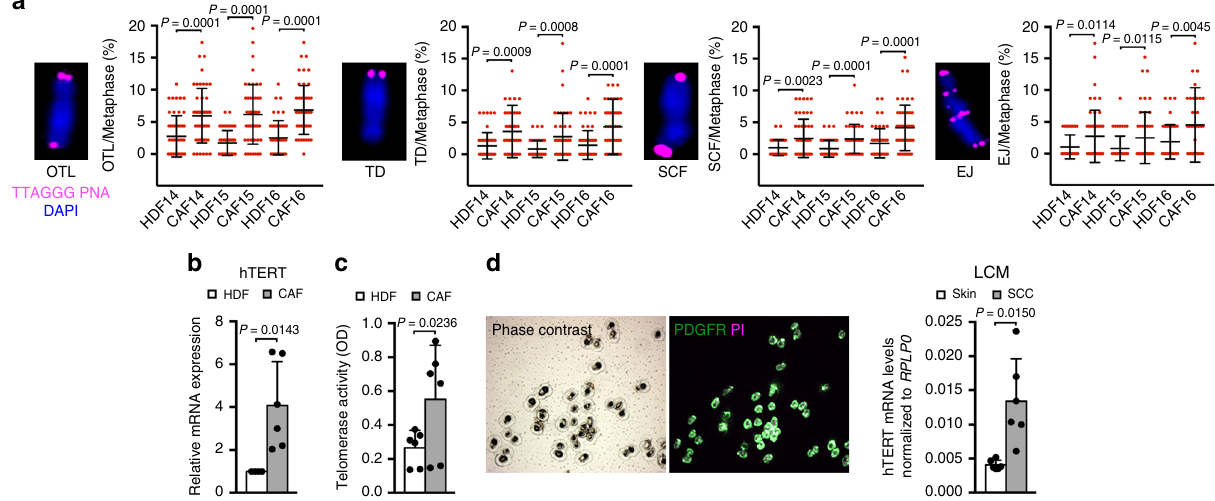
Fig. 4 CAFs display persistent genomic instability and hTERT reactivation. a Representative images and quanti fi cation of the percentage of chromosomes carrying OTLs, TDs, SCFs, and EJs per metaphase in three CAF and matched HDF strains. Data are shown as in Fig. 3f, g. Mean ± SD, n (spread) = 47, n (CAF strain) = 3, n (matched HDF strain) = 3, * p < 0.05, two-tailed unpaired t -test. b RT-qPCR analysis of hTERT expression, normalized to RPLP0 , in six CAF and matched HDF strains. n (CAF strain) = 6, n (matched HDF strain) = 6, * p < 0.05, two-tailed paired t -test. c Telomerase activity measured in the same six CAF and matched HDF strains as in b. n (CAF strain) = 6, n (matched HDF strain) = 6, * p < 0.05, two-tailed paired t -test. d RT-qPCR analysis of hTERT expression, normalized to RPLP0 , of in situ SCCs, and matched unaffected skin sections (from which CAFs and HDFs in Fig. 4b were derived) processed for fl uorescence-guided laser capture microdissection (LCM) utilizing anti-PDGFR α -FITC conjugated antibodies (green) and propidium iodide (PI, magenta) staining for nuclei identi fi cation. Shown are also representative images of cells captured on LCM caps. n (SCC CAF) = 6, n (matched HDF) = 6, * p < 0.05, two-tailed paired t -test. Bars represent mean ±